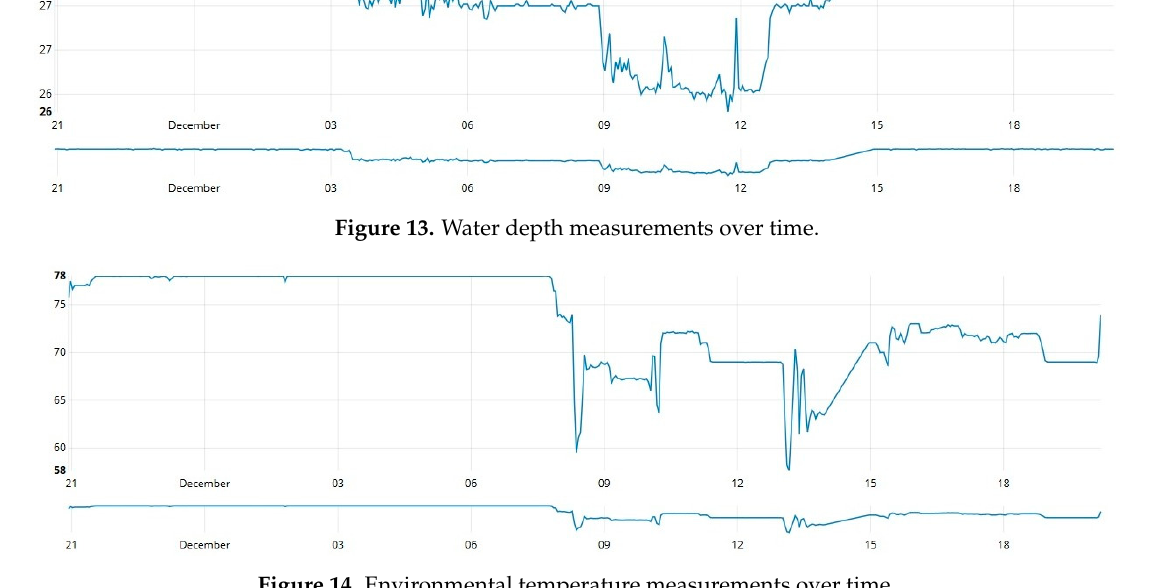
Figure 14. Environmental temperature measurements over time.